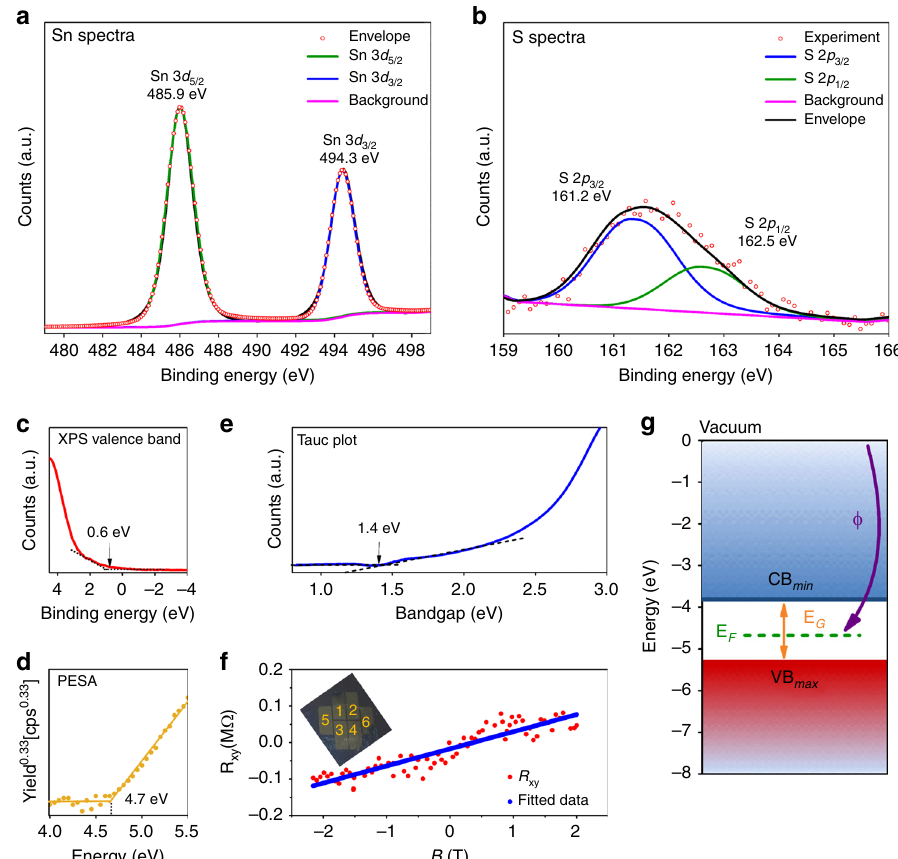
Fig. 2 Compositional and electronic characterisations of the synthesised monolayer SnS. a Sn 3 d XPS spectra deconvoluted and fi tted to show the typical peaks of Sn 2 + binding energies at 485.9 and 494.3 eV. b S 2 p XPS spectra deconvoluted and fi tted to show peaks at binding energies of 161.2 and 162.5 eV c XPS valence band spectrum indicating the energy difference between the Fermi level and the valence band maximum is ~0.6 eV. d PESA spectrum where it is observed that the Fermi energy level is ~4.7 eV below vacuum (cps-counts s − 1 ). e Tauc plot converted from the UV-Visible spectroscopy indicates the optical bandgap as ~1.4 eV. f Hall resistance (R xy ) of the monolayer SnS as a function of the applied magnetic fi eld (B) with optical image of